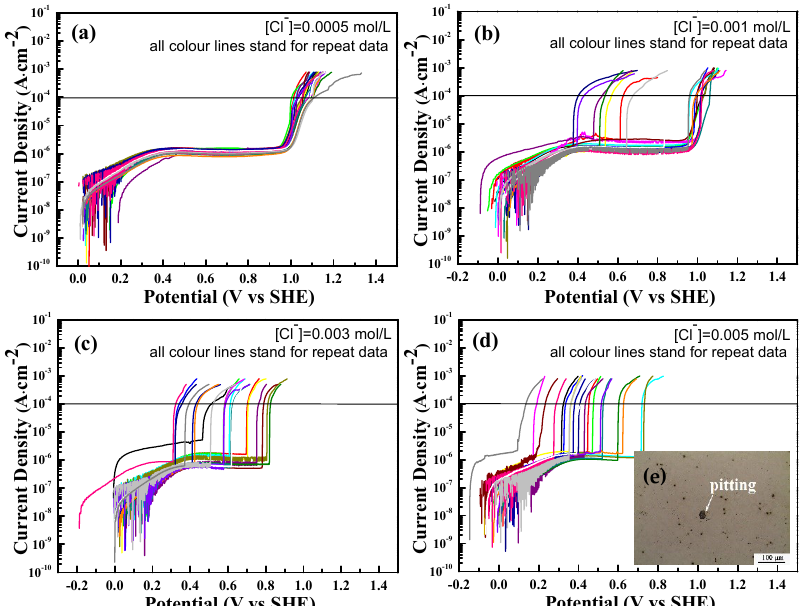
Figure 7. Anodic polarization curves for reinforcing bars in simulated concrete pore solutions with various concentrations of chloride ions at pH 11.5; ( a ) 0.0005 mol/L, ( b ) 0.001 mol/L, ( c ) 0.003 mol/L, and ( d ) 0.005mol/L. ( e ) shows the pitting corrosion after the anodic polarization test.